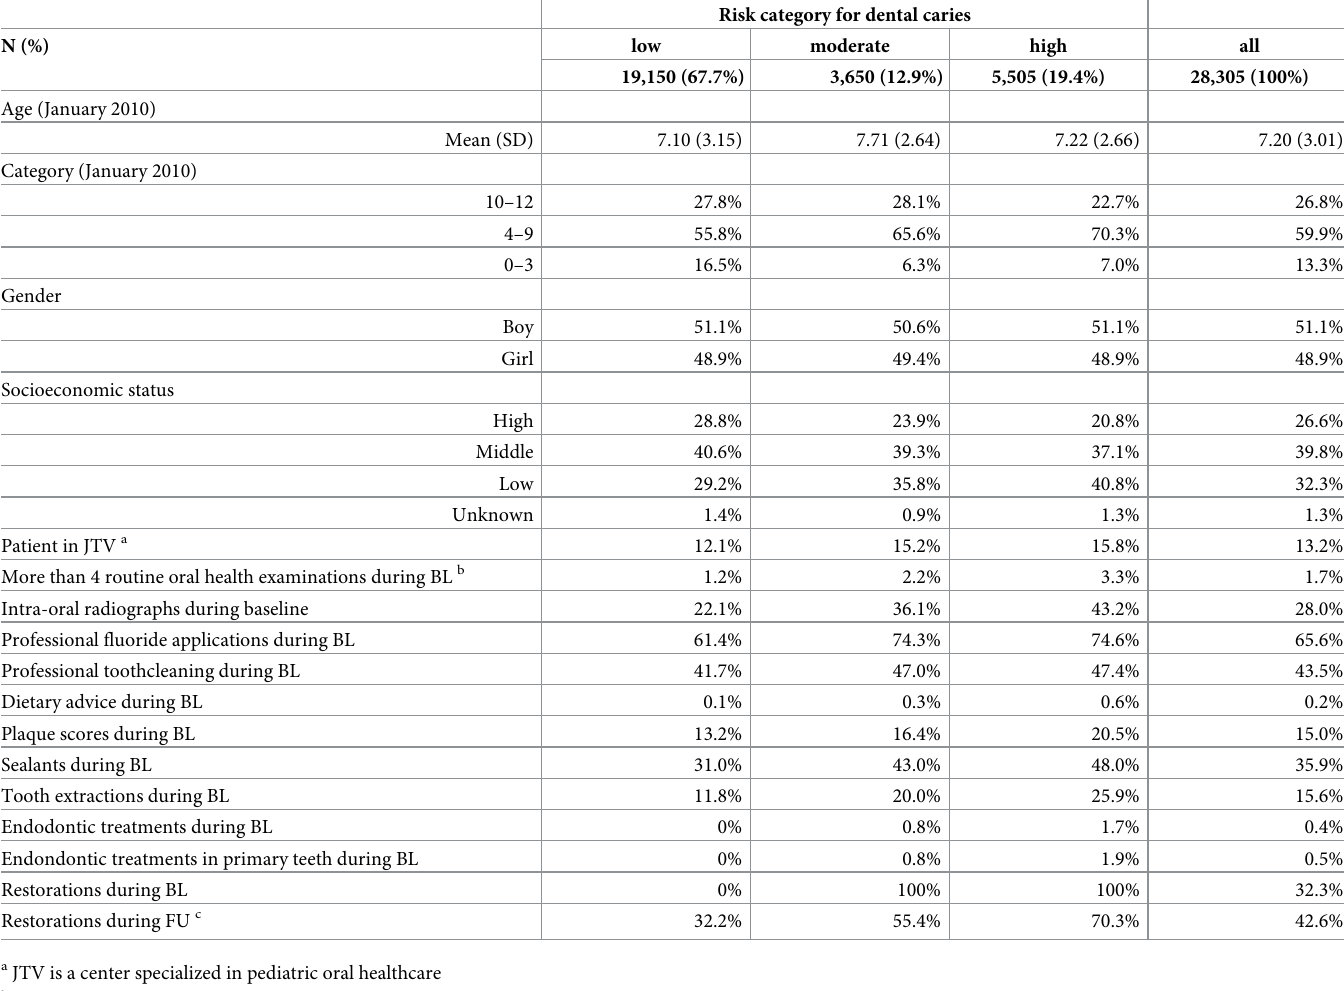
Table 2. Description of the variables per risk category for dental